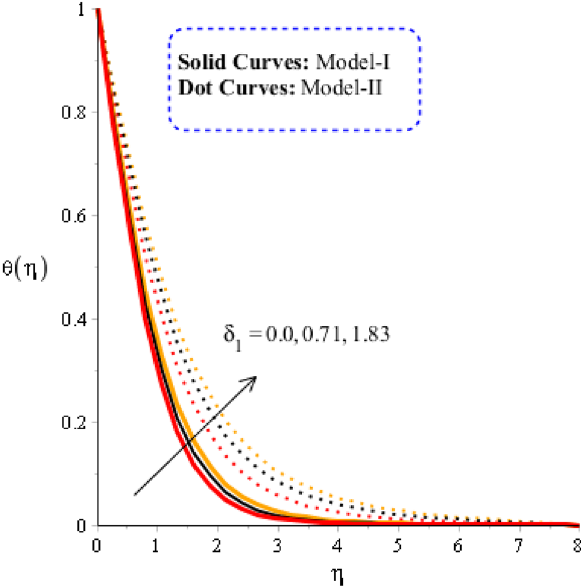
Figure 7. Graphical impact of δ 1 on thermal distribution when α = 0.5, m = 0.3, Re = 4.0, we = 3.0, M = 3.0, Pr = 206, H t = − 2.0, Sc = 0.0, ϕ 1 = 0.003, ϕ 2 = 0.004, ϕ 3 = 0.0075, K c = − 2.0.